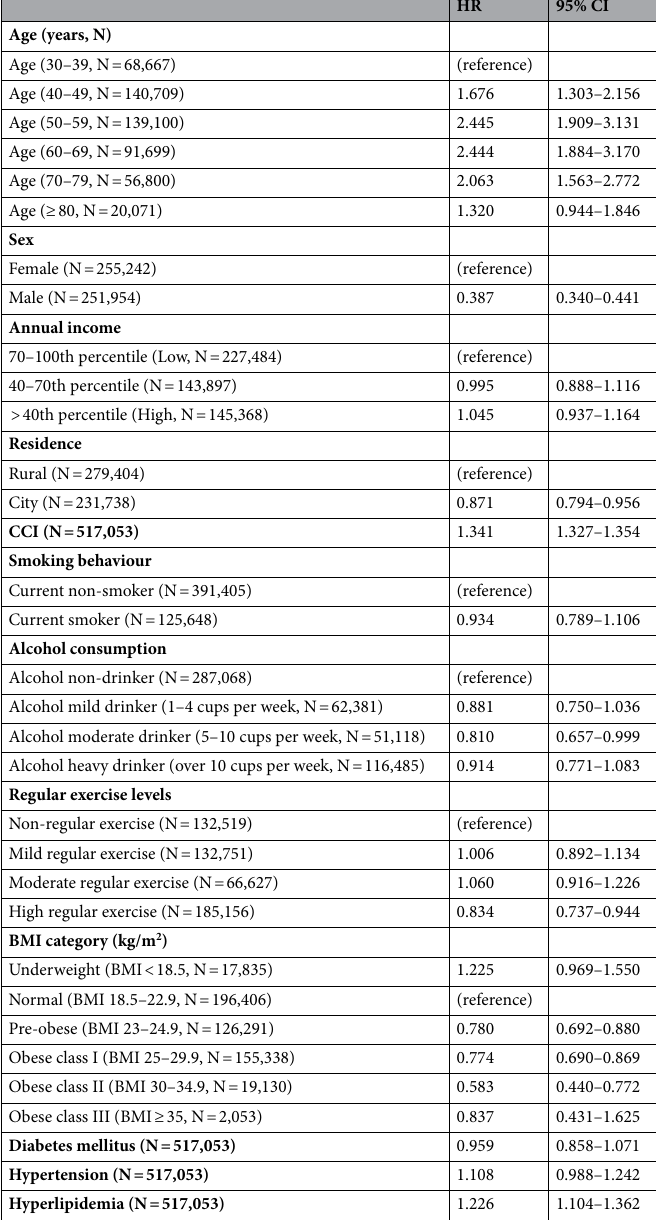
Table 2. Multivariate Cox proportional regression analysis for seropositive rheumatoid arthritis